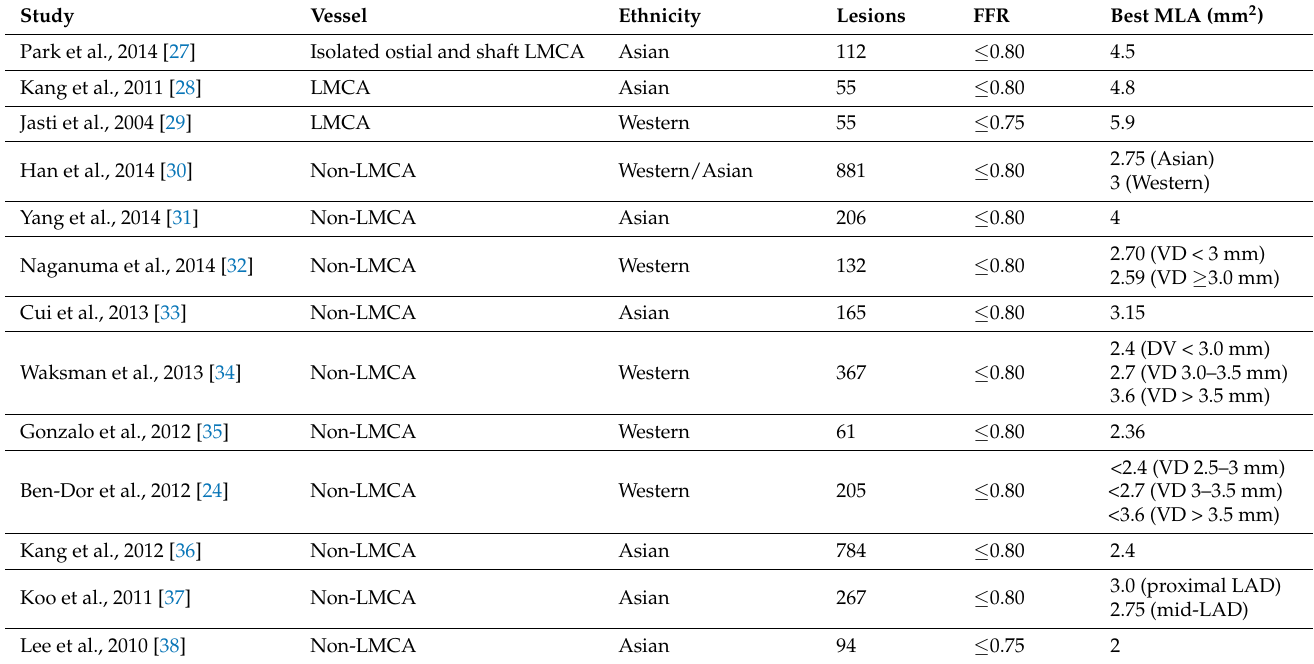
Table 1. Intravascular ultrasound-derived optimal minimal luminal area values to predict fractional flow rate in left main coronary artery (LMCA) and